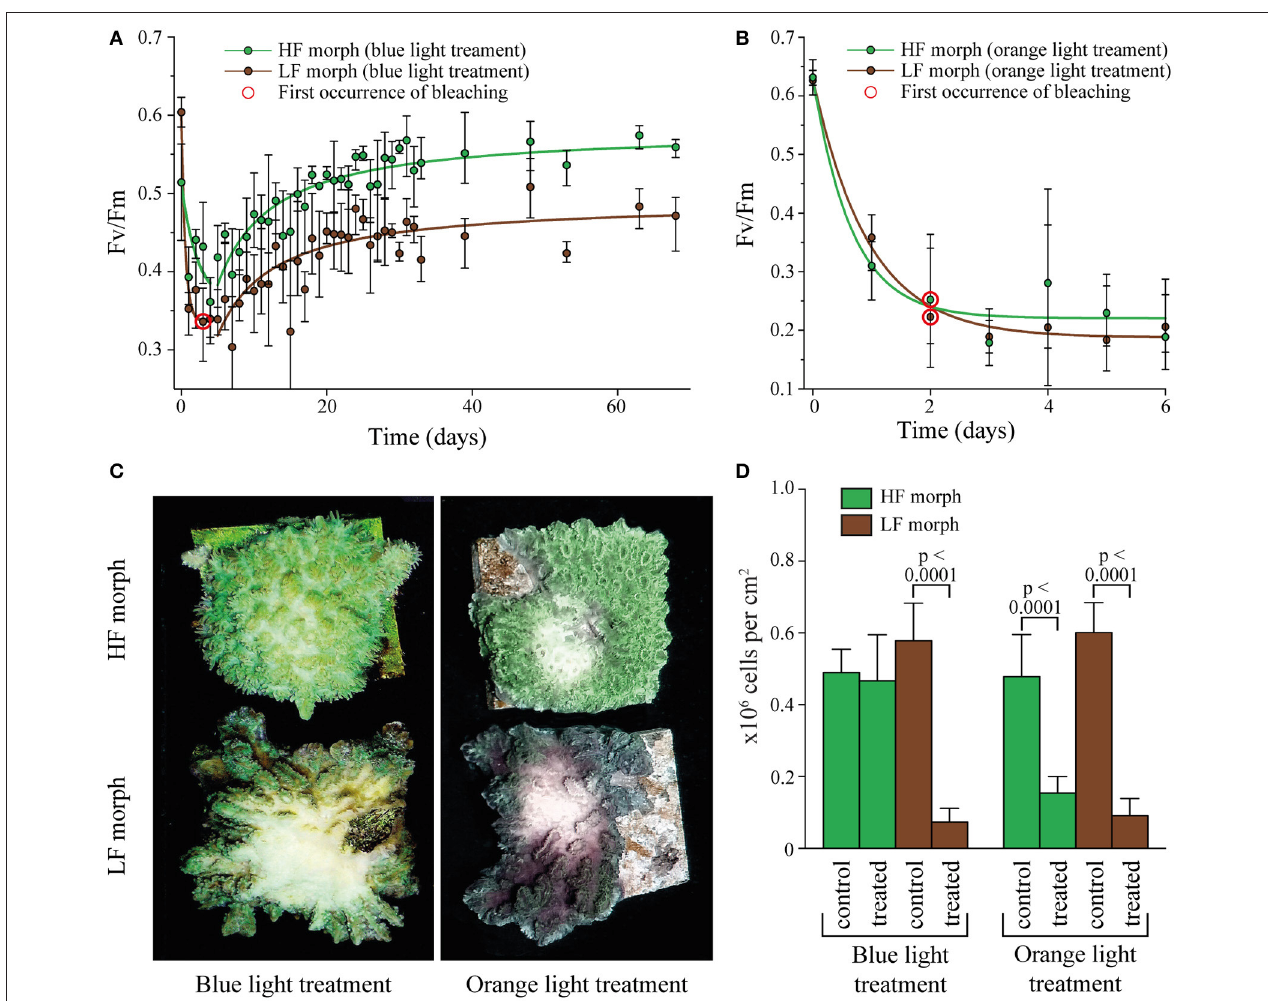
FIGURE 2 | (A) Change in Fv/Fm in two color morphs of Hydnophora grandis under high intensity blue light (2,000 µ mol photons m − 2 s − 1 ). Error bars indicate the range of mean values of 3 replicate colonies. Red circles highlight the first occurrence of visible bleaching. Lines represent exponential decay and saturation fits, respectively. (B) Change in Fv/Fm in the HF and LF color morphs of Hydnophora grandis under high intensity orange light (2,000 µ mol photons m − 2 s − 1 ). Error bars indicate the range of mean values of 3 replicate colonies. The first occurrence of visible bleaching is marked by red circles. Lines represent exponential decay fits. (C) Photographs of representative colonies of the HF morph (top) and LF morph (bottom) taken at the end of the high intensity blue light (left) and orange light (right) treatments. (D) Concentration of zooxanthellae in tissue samples of both morphs after exposure to 2,000 µ mol photons m − 2 s − 1 of blue and orange light (treated) and control tissue samples exposed to ambient light intensities (control). Error bars show standard deviation. Brackets above two bars indicate p -values for statistically significant ( p < 0.05) differences between the zooxanthellae concentrations in treated and untreated tissue samples of each morph under blue and orange light, determined using unpaired t